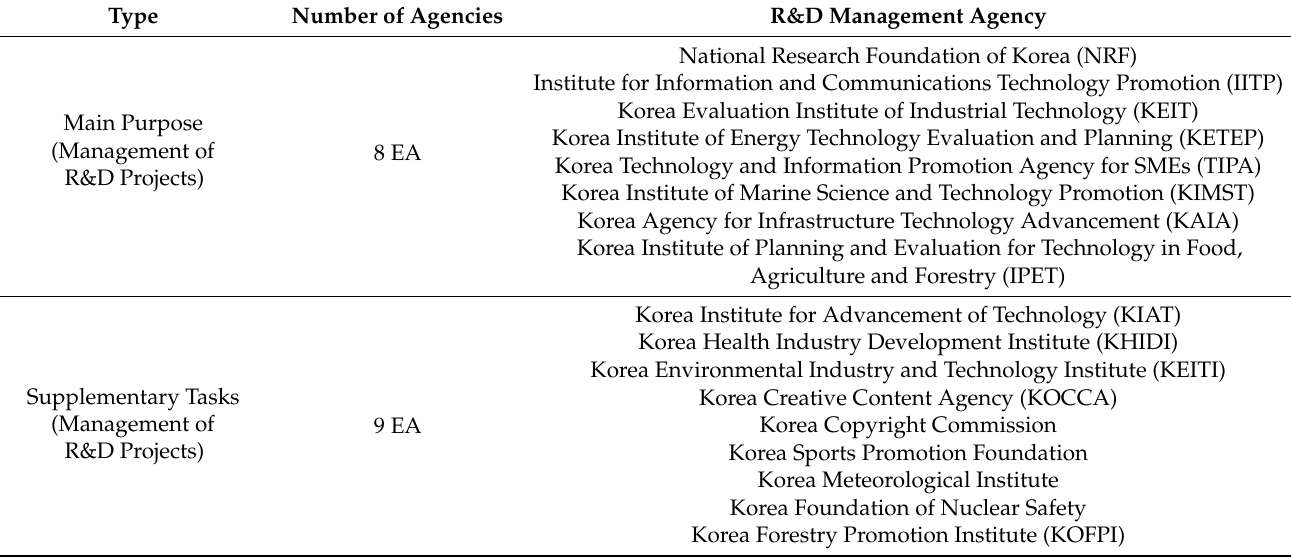
Table 1. Current status of R&D management agencies